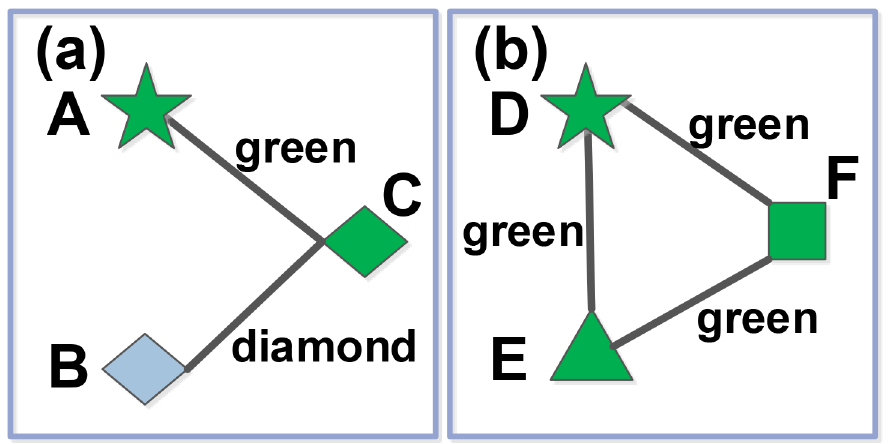
Fig 2. Illustration of similarity redundancy. A, B, D and E are collectedobjects, and C and F are the uncollected. Object pairs (A, C) and (B, C) respectively have similarities of color green and geometry diamond. So there is no similarity redundancy betweenA and B. However, (D, F) and (E, F) both have the similarity of color green so that D and E possess the similarity redundancy of color green.